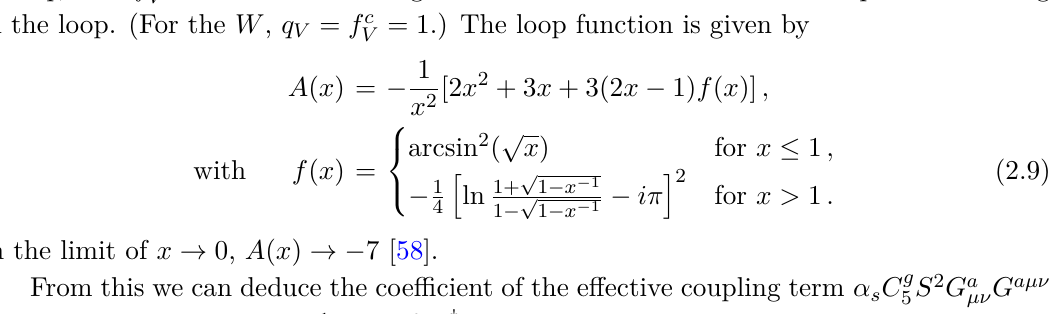
¯ Figure 2 . Diagram generating the SS ff coupling. If f is a quark, f 0 is a lepton and vice-versa. Here q and f c are the electric charge and the colour factor of the vector particle V V